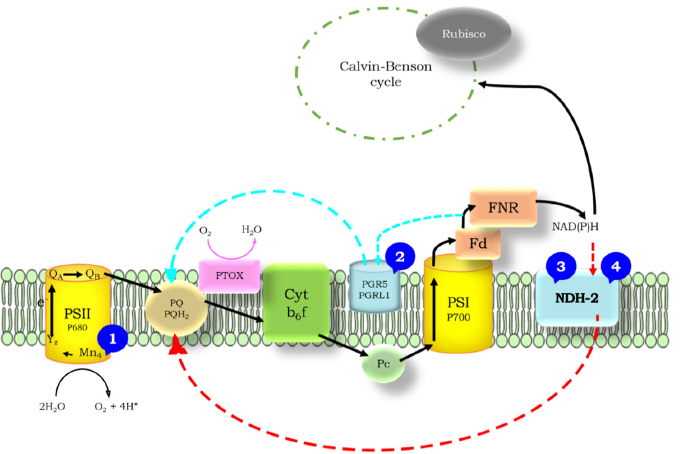
Figure 7. Schematic representation of the electron transfer pathways in microalgae. Specific inhibitors used in this study and sites of their action are represented by blue circles with corresponding numbers: Hydroxylamine ( 1 ), an inhibitor of the donor side of PSII; Antimycin A ( 2 ), an inhibitor of the PGR5/PGRL1 pathway, which blocked the wave phenomenon in C. sorokiniana ; Polymyxin B ( 3 ); DPI ( 4 ), inhibitors of the NDH-2 pathway. Polymyxin B and DPI partially blocked the wave in D. salina , DPI completely blocked the wave in H. pluvialis red cells. The LEF pathway is indicated in black arrows and the NDH-2-dependent and PGR5/PGRL1-dependent CEF pathways taking place inside the membrane are indicated by red and cyan dashed arrows,